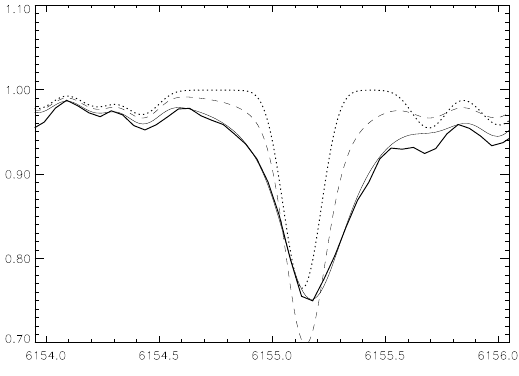
Fig. 2. A comparison between the observed SiI, 6155 (cid:23)A line pro(cid:12)le in the spectrum of Ap star 10 Aql (thick line) and synthetic spectra calculated with Stark widths and shifts from Table 1 in Dimitrijevi(cid:19)c et al. (2003b) and Si abundance strati(cid:12)cation (thin line), with the same Stark parameters but for homogeneous Si distribution (dashed line), and with Stark width calculated by approximation formulae for the same strati(cid:12)cation (dotted